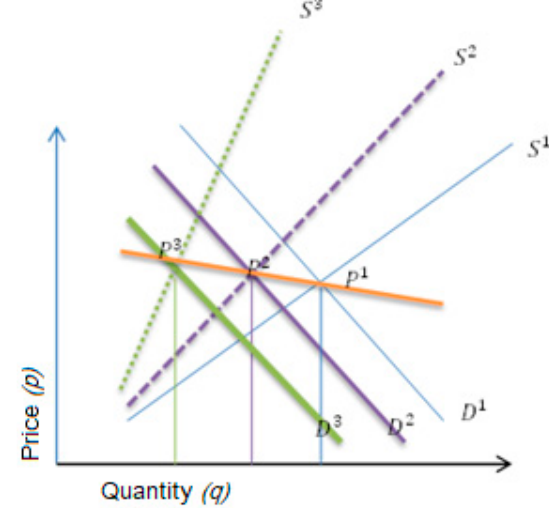
Figure 4. Cycle of demand and supply.